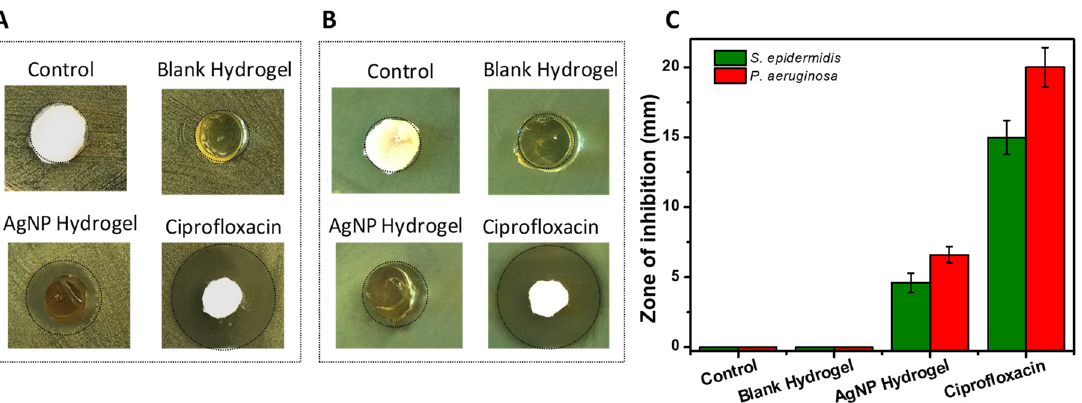
Figure 5. ( A , B ) Representative images of the zone of inhibition of negative control, blank hydrogel, AgNPs loaded hydrogel, and Ciprofloxacin as positive control tested against S. epidermidis ( A ) and P. aeruginosa ( B ). ( C ) Quantification of the corresponding zones of inhibition. Data are shown as mean ±SD.